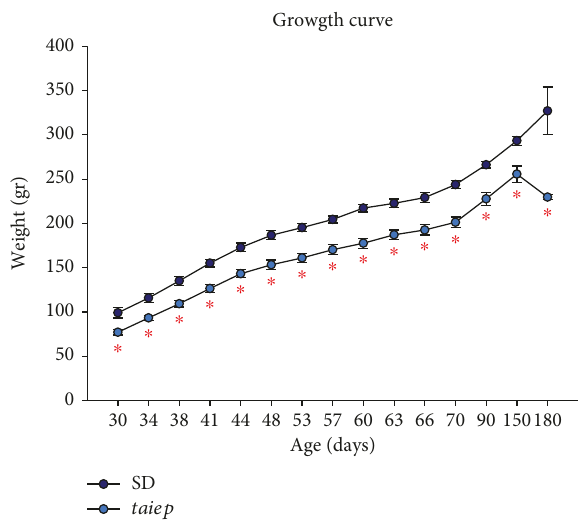
Figure 2: Plot of growth curve and weight (gr) with respect to age in days. Values are the mean and the error bars represent the standard error of measurements for 6 Sprague – Dawley rats (SD) or taiep rats in di ff erent ages of development. Comparisons were analyzed with an ANOVA followed by a Tukey ’ s test, ∗ p ≤ 0 001